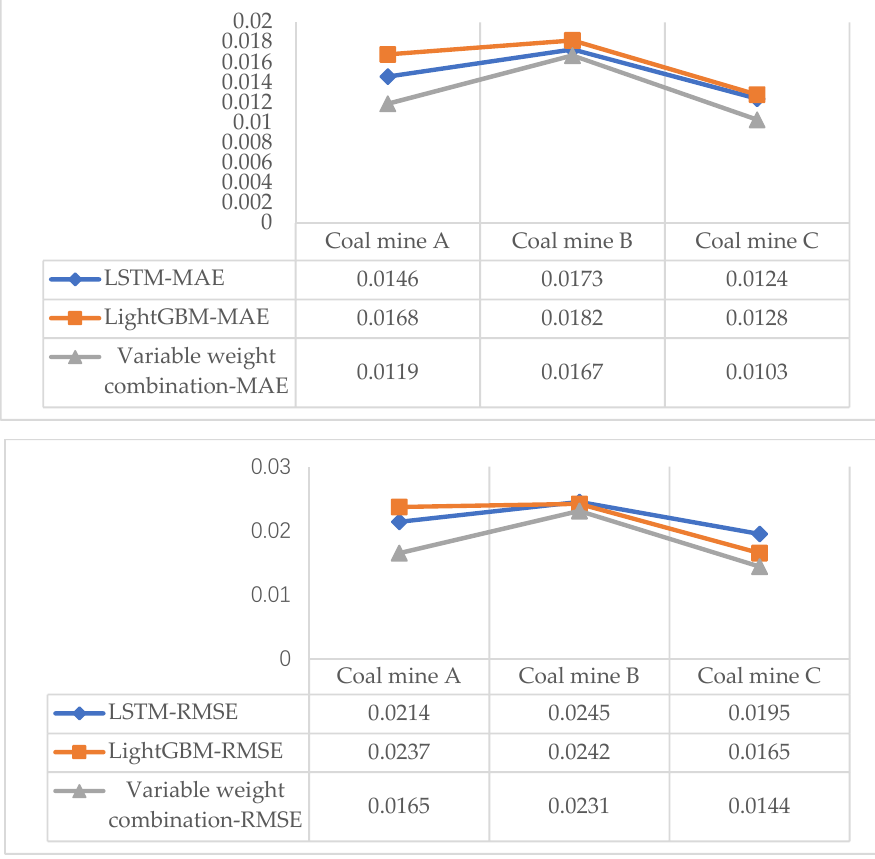
Figure 7. Analysis of evaluation index applied to different coal mines.